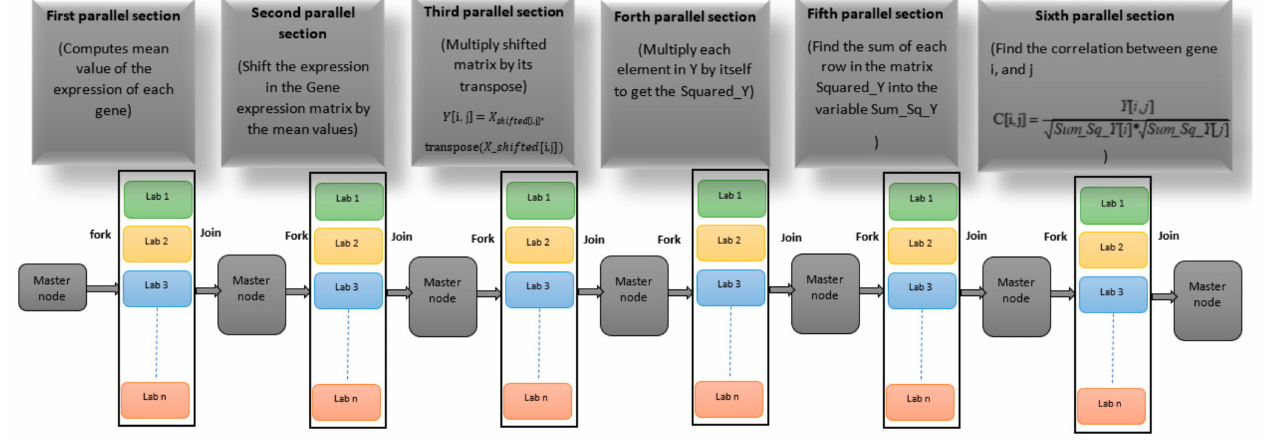
Figure 4. A fork–join model for computing the correlation matrix in gene co-expression networks.